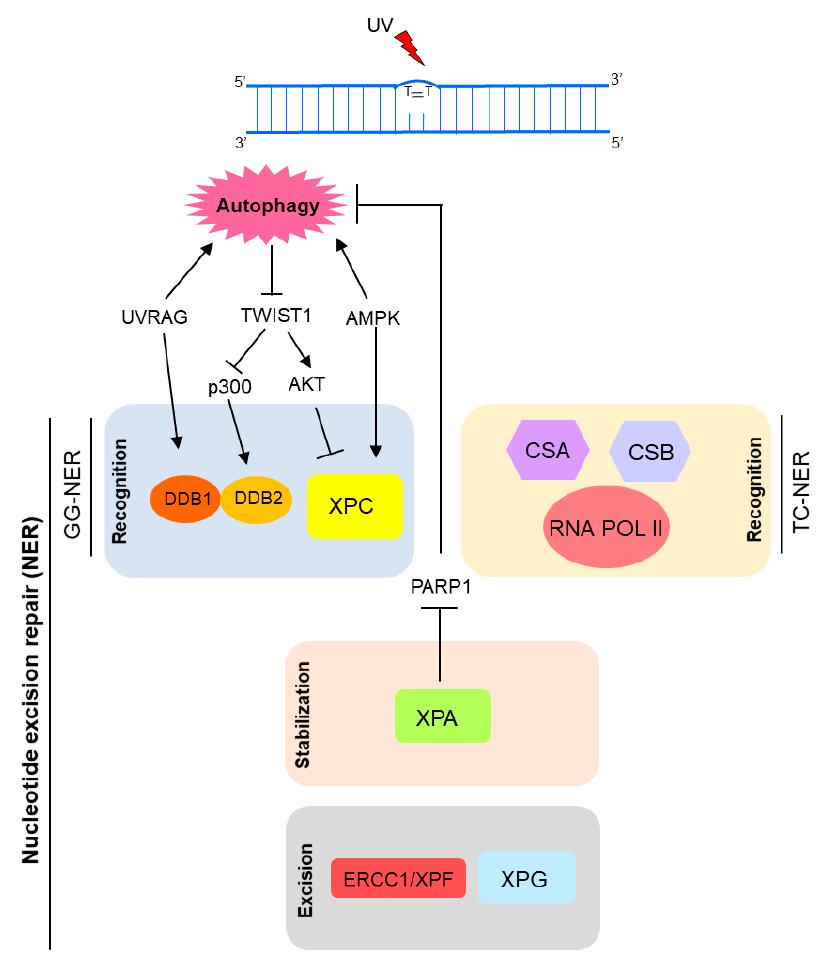
Figure 5. Model of NER regulation by autophagy. Autophagy controls crucial molecular players of the recognition step of the global genome (GG) NER, including damaged-DNA binding protein (DDB)1, DDB2, and XPC. Moreover, XPA (also essential for transcription-coupled (TC) NER)